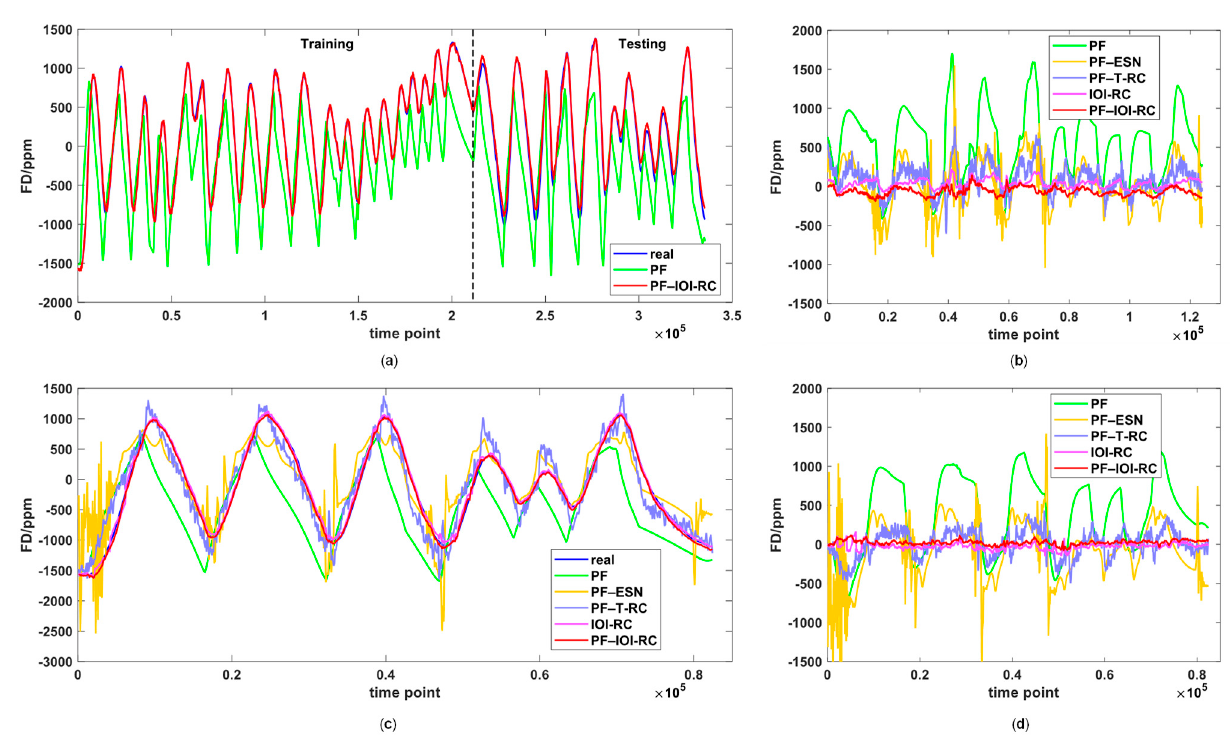
Figure 6. Frequency prediction curves and residual error curves of the three datasets. ( a ) The real and predicted FD of TrDs and TeDs1. ( b ) The remaining FD error after compensation of TeDs1. ( c ) The real and predicted FD of TeDs2. ( d ) The remaining FD error after compensation of TeDs2.